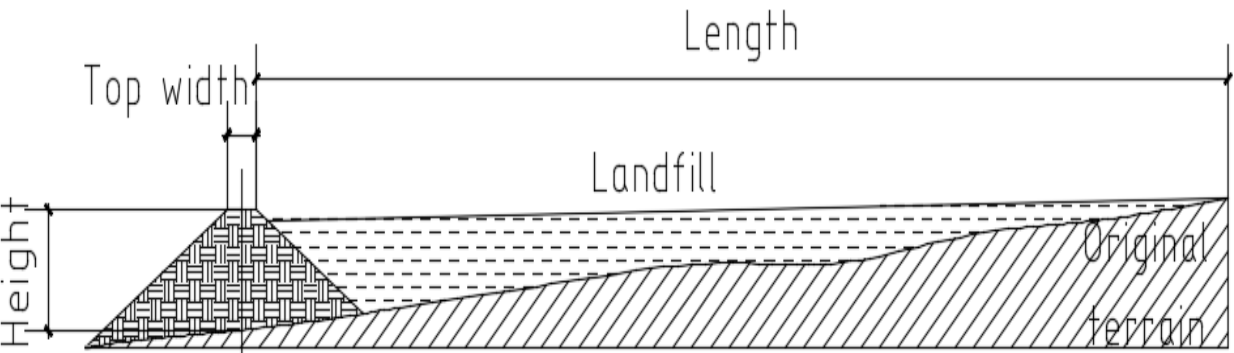
Figure 6. Gully land consolidation profile ( λ l = = 100 ). l